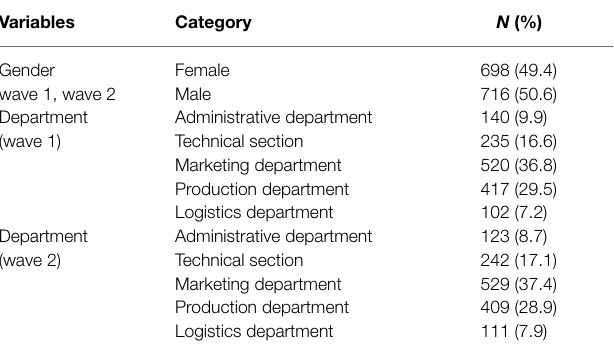
TABLE 1 | Demographic characteristics of the participants ( N =